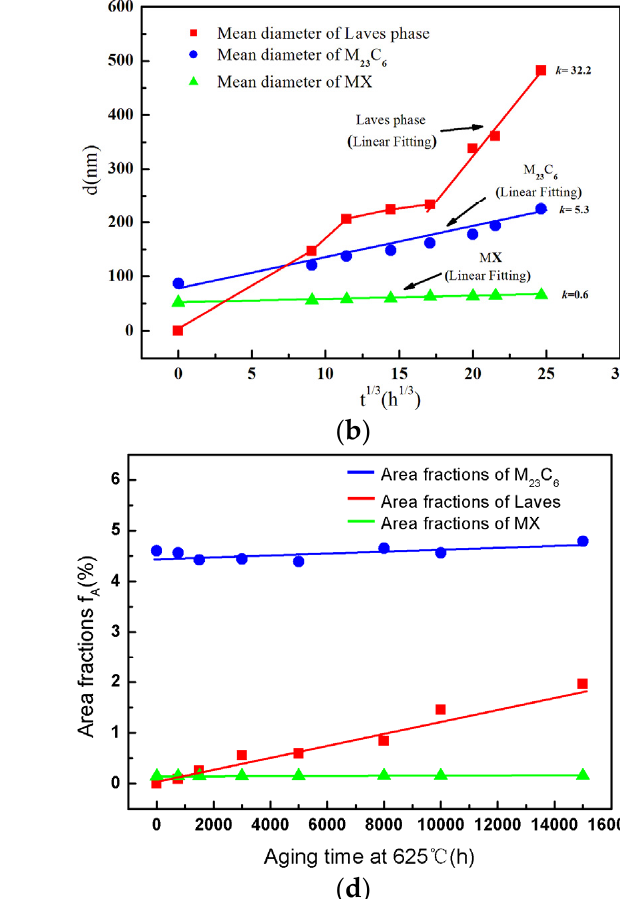
Figure 4. Coarsening kinetics, number densities and area fractions of precipitates the P91 steel during long-term aging: ( a ) d as a function of t for M23C6, Laves phase and MX; ( b ) d as a function of t 1/3 ; ( c ) Number densities; ( d ) Area fractions.